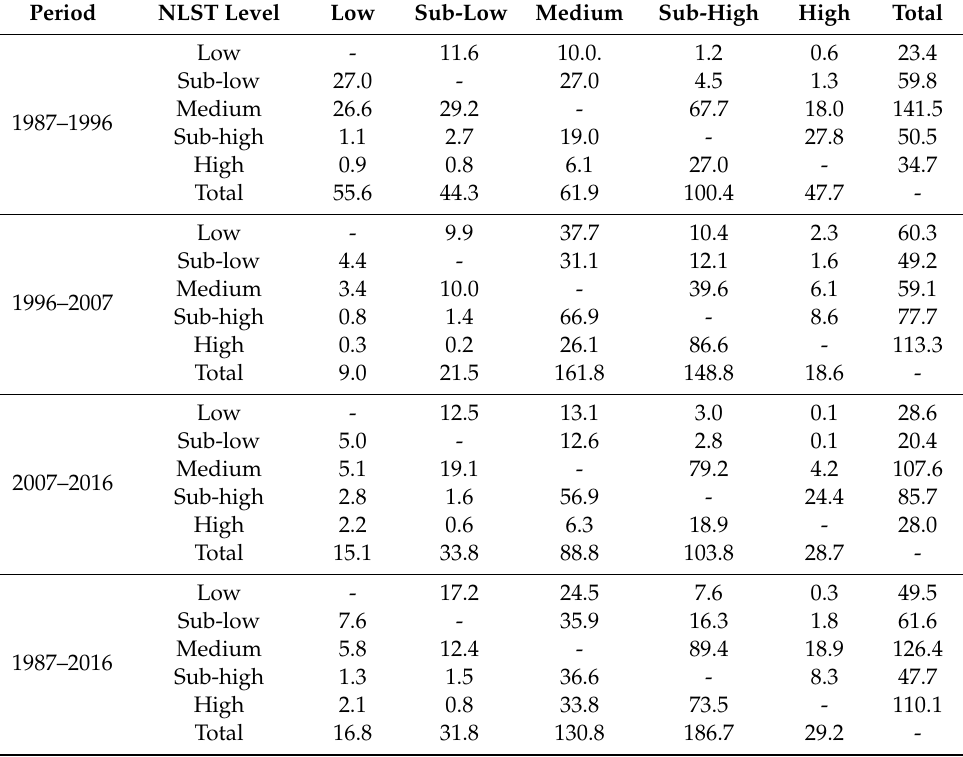
Table 4. Transfer matrix among di ff erent NLST levels during 1987–2016 (km 2 ). Period NLST Level